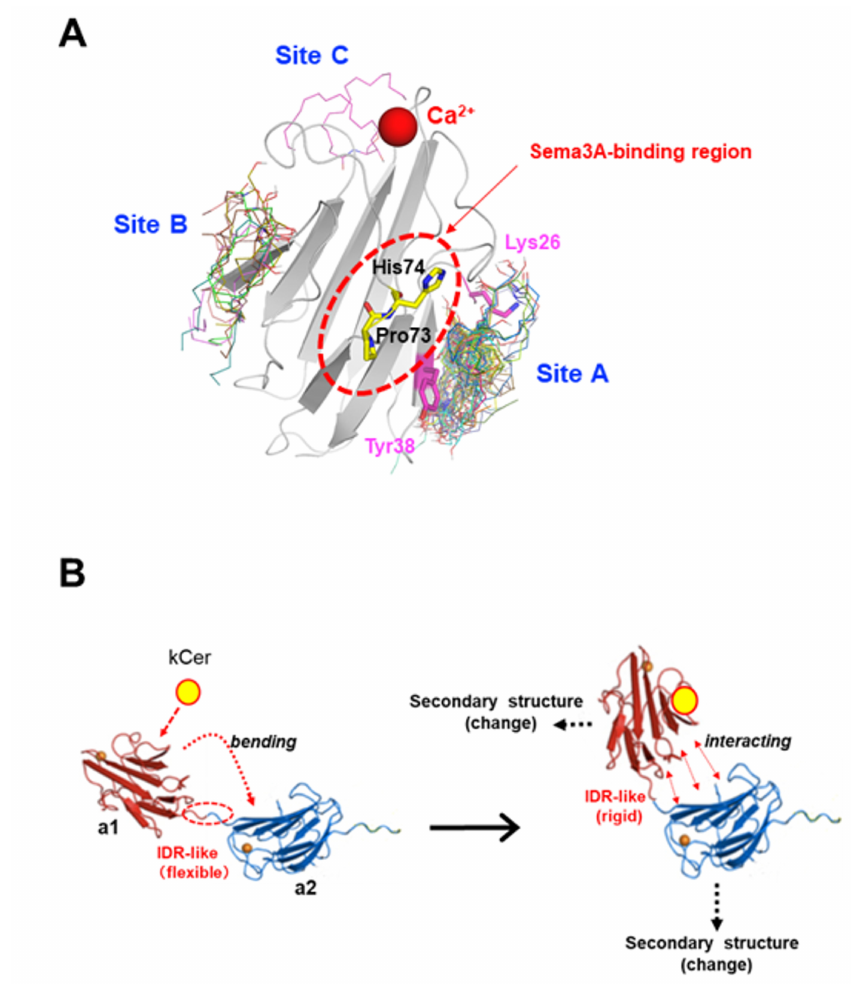
Figure 7. ( A ) Molecular docking simulation for the a1 module and d4t,8t-C16kCer, and artificial species of kCer composed of C16:0 fatty acid and d4t,8t-sphingadienine. There are three binding sites (A, B, and C) on the a1 protein. Site a is located near the Sema3A binding region. ( B ) Possible activation mechanism of Nrp1 by kCer. The sole a1 module is far away from a2 and b1b2 (Figure S4B). intrinsically disordered region (IDR)-like flexibility likely occurs due to the distance between a1 and a2 modules. When kCer binds to Site a of the a1 module, the IDR-like flexibility between a1 and a2 diminishes, and the IDR-like region rigidifies, strengthening the intermolecular interactions between a1 and a2, resulting in a slight change in protein secondary